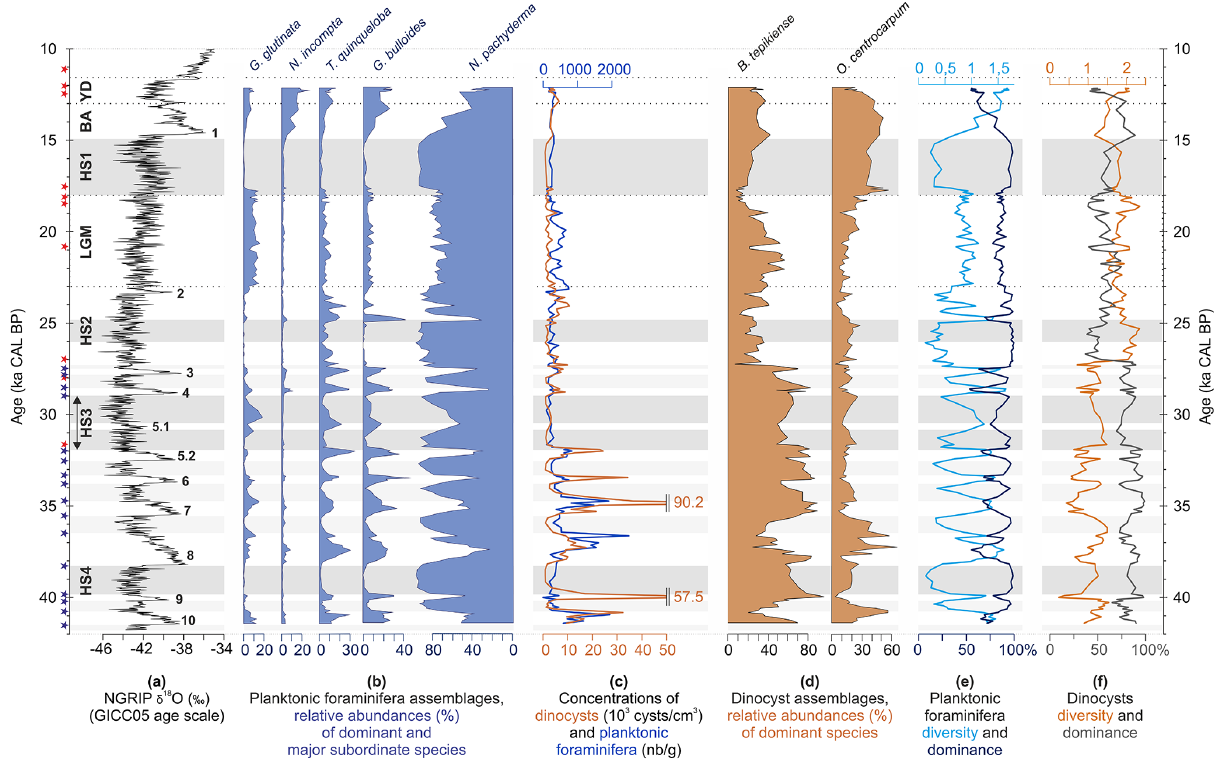
Figure 2. Evolution of index micro-planktonic assemblages compared to (a) NGRIP-GICC05 δ 18 O record: (b) relative abundances of the dominant planktonic foraminifera species, (c) absolute abundances (no. of specimen in the sediment) of dinocysts and planktonic foraminifera, (d) relative abundances of dominant dinocyst species, (e) planktonic foraminifera diversity and dominance (see calculations in Sect. 3.2.), and (f) dinocyst diversity and dominance. Red stars indicate AMS 14 C dates used, and blue stars show the tie points obtained by comparing the MD99-2281 magnetic susceptibility record to the NGRIP δ 18 O signal (see Zumaque et al., 2012). GS and HS are highlighted by light- and dark-grey bands, respectively (age limits after Wolff et al., 2010). DO cycles are numbered according to corresponding GI numbers in Dansgaard et al. (1993), except for GI 5, which was divided into GI 5.2 and GI 5.1 according to Rasmussen et al. (2014). LGM stands for Last Glacial Maximum, BA for Bølling–Allerød, and YD for Younger